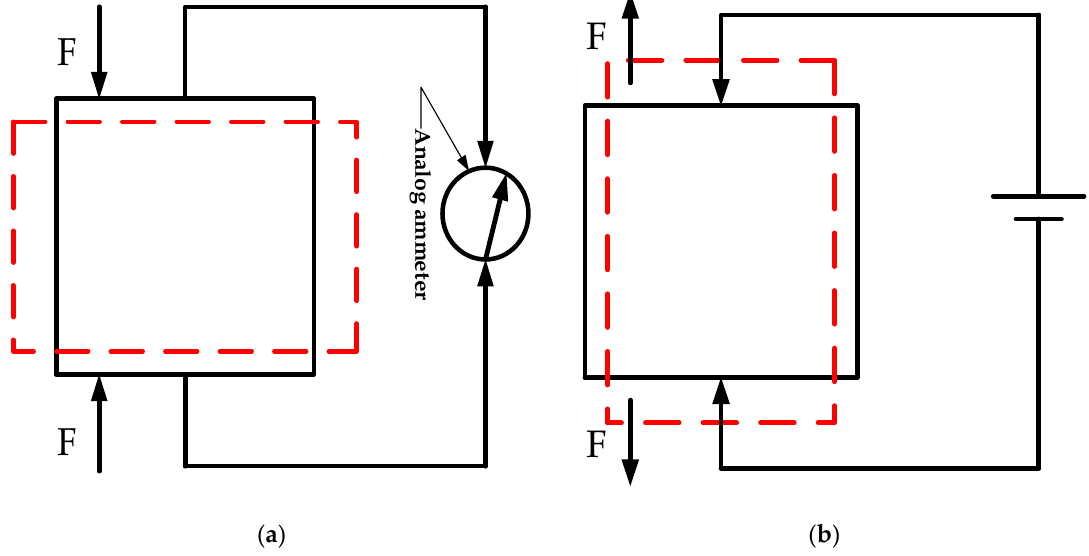
Figure 2. Piezoelectric effect diagram (Red dashed lines indicate after deformation): ( a ) Direct piezoelectric effect diagram; ( b ) Inverse piezoelectric effect diagram. The black rectangle represents the original shape of the piezoelectric ceramic block, and the red dashed rectangle represents the deformed shape.